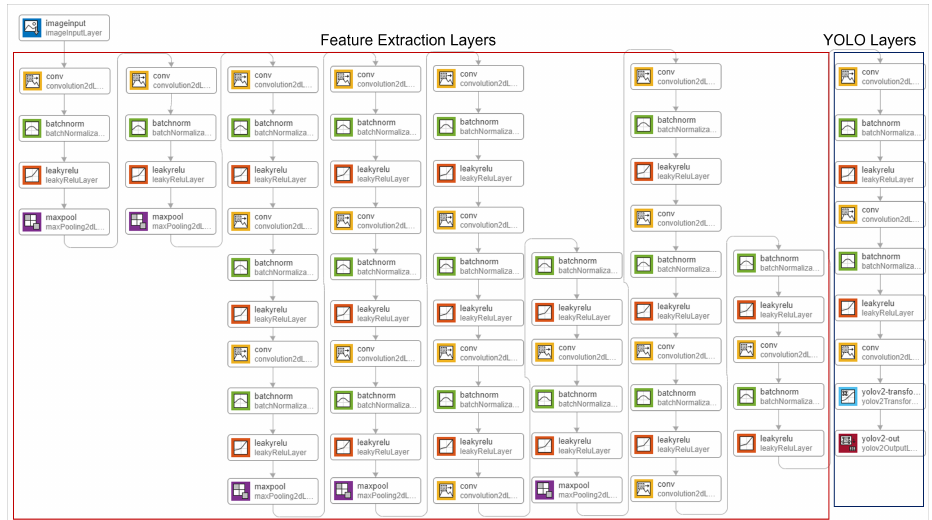
Figure 10. YOLOv2 with DarkNet feature